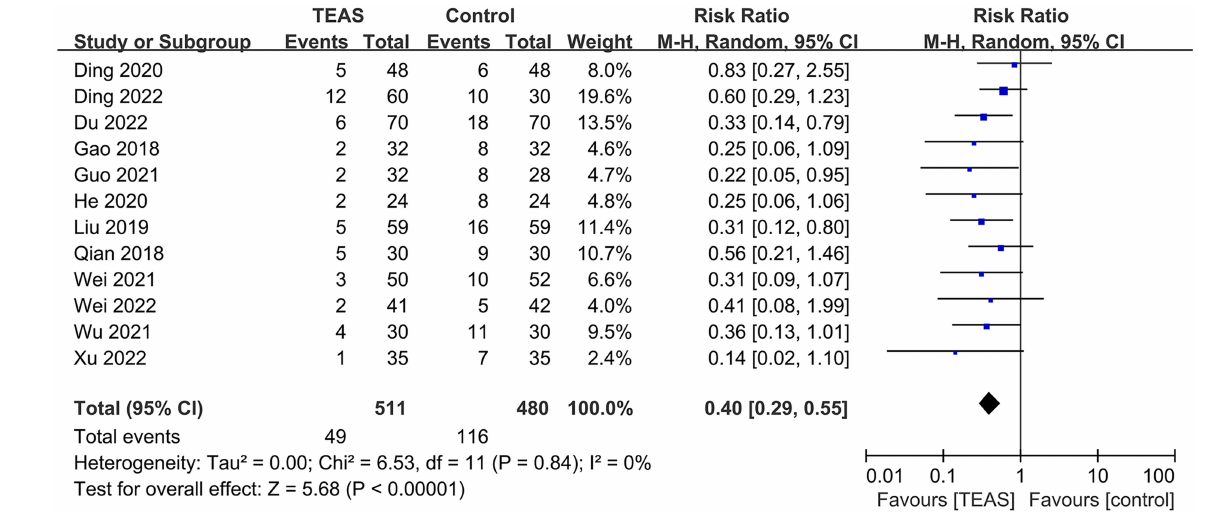
FIGURE 3 Forest plot of the incidence of POD.